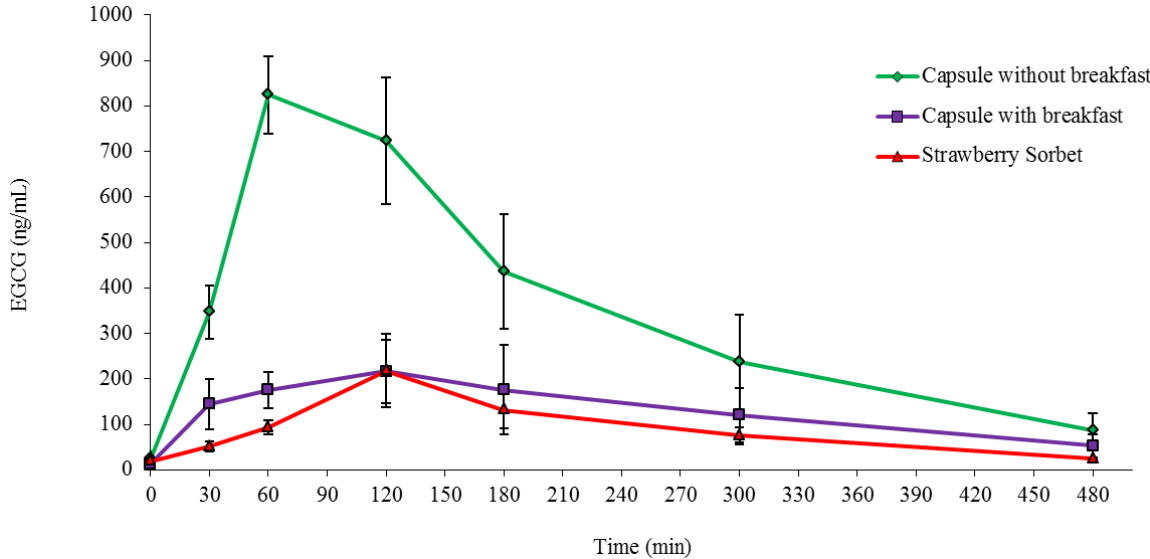
Figure 5. The mean plasma EGCG concentration-time curves for the three different methods of oral delivery: capsules without breakfast (green), capsules with breakfast (purple) and strawberry sorbet (red). The values are means ± the standard error of the means for the four participants ( n = 4). Table 5. Plasma kinetic parameters for EGCG after the three different methods of ingestion. EGCG Capsules Without Breakfast With